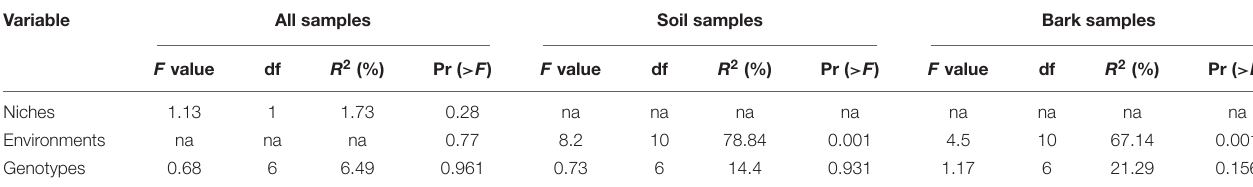
TABLE 1 | The influences of host niche, genotype, and environmental factors on the bacterial community of E. ulmoides based on PERMANOVA. Variable All samples Soil samples Bark